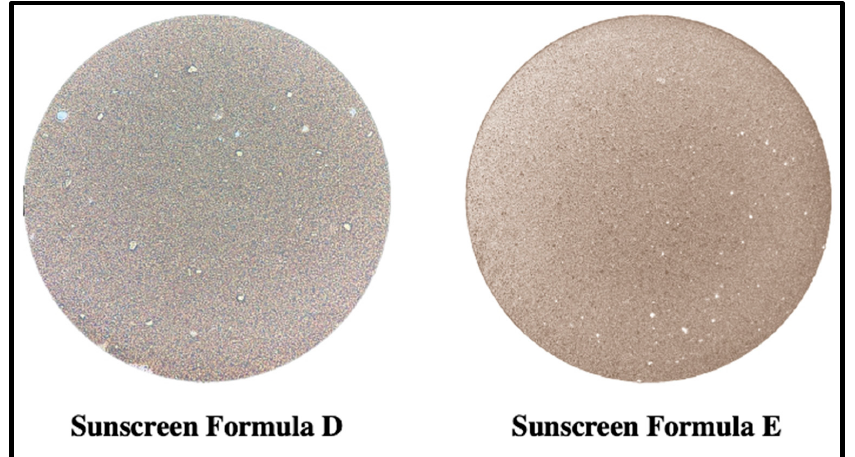
Figure 2. The data reflect the particle size of the two types of TiO 2 used: in Sunscreen Formula D it is nanometric, while in Sunscreen Formula E the size of the aggregates (about 500 nm) is comparable with the wavelengths of visible